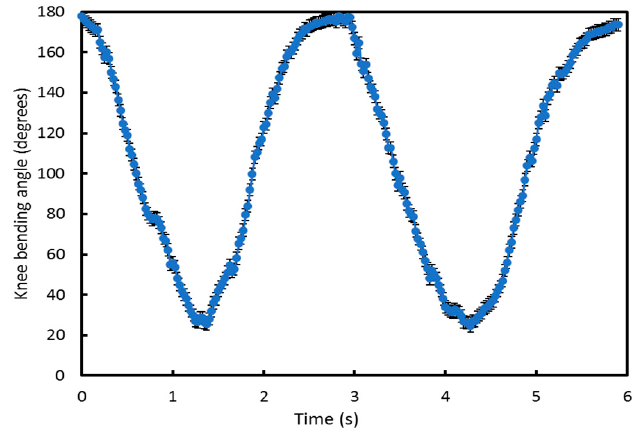
Figure 10. Knee joint bending angle measured by the e-textile movement sensor.